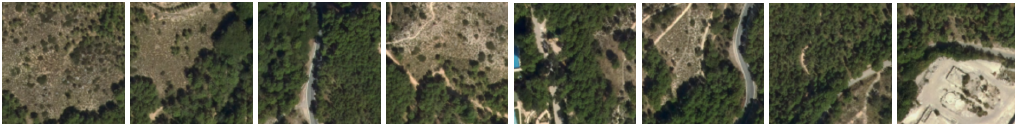
Figure 4. Sample predictions for three randomly selected zones outside the dataset that were not used for training. “p_road” shows the network prediction confidence for the class “contains